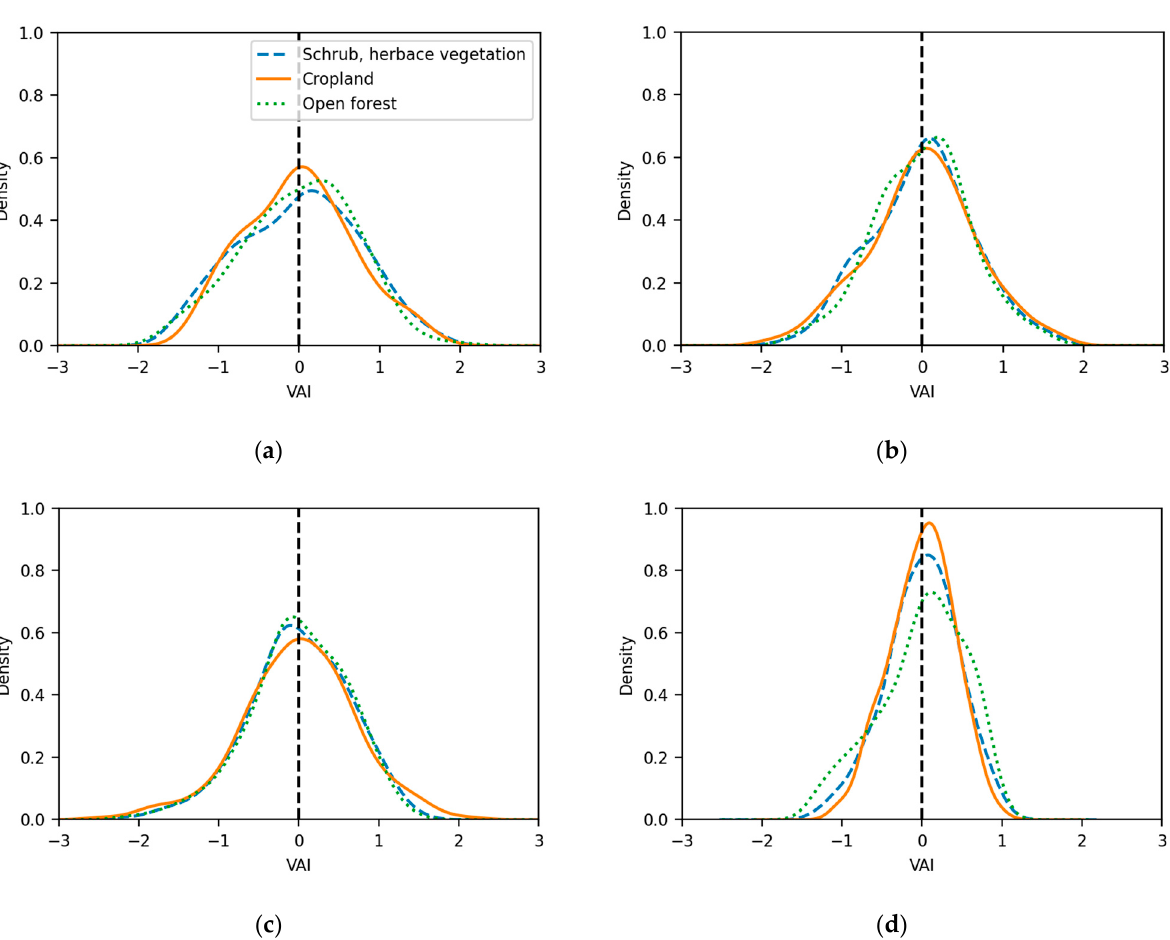
Figure 4. Distributions of the VAI values for the three land uses (crops, shrub and herbaceous vegetation, and open forest), ( a ) Kairouan; ( b ) Ain Dafla; ( c ) Rif; ( d )